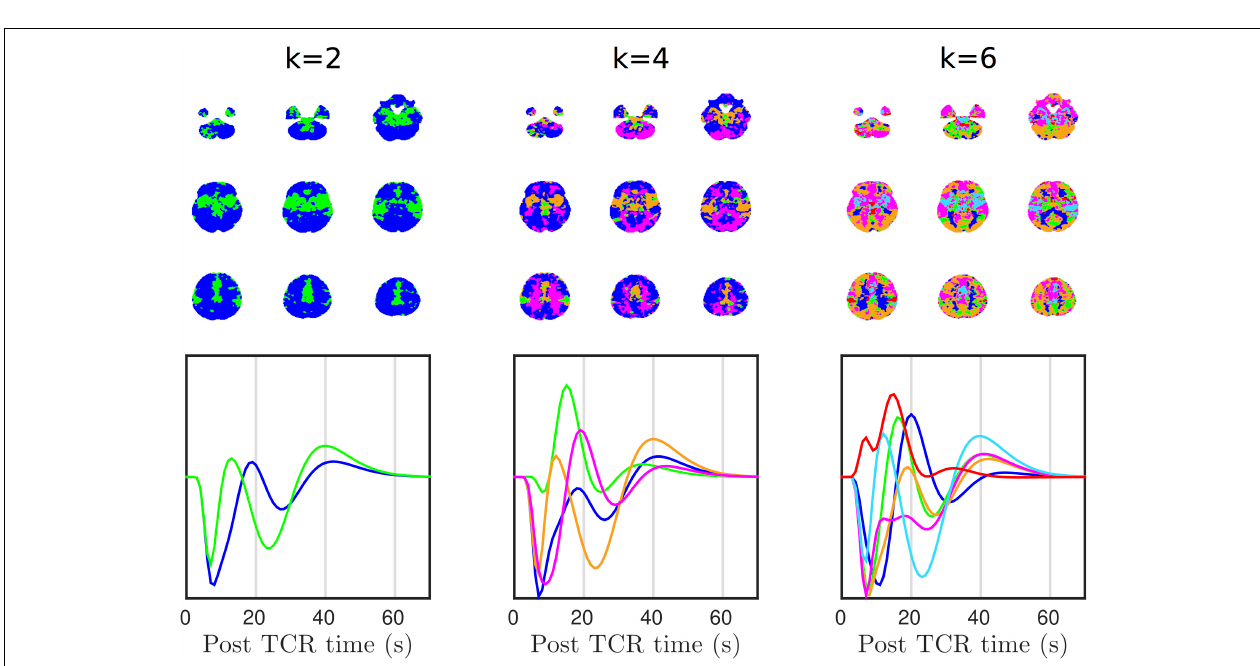
FIGURE 6 | K-means clustering shows that there is structured spatial heterogeneity in HRF TCR .